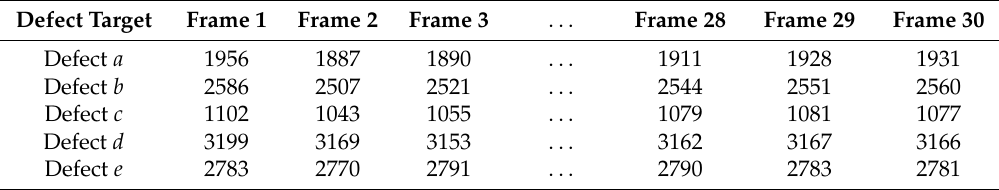
Table 1. The results of area calculation of surface defect